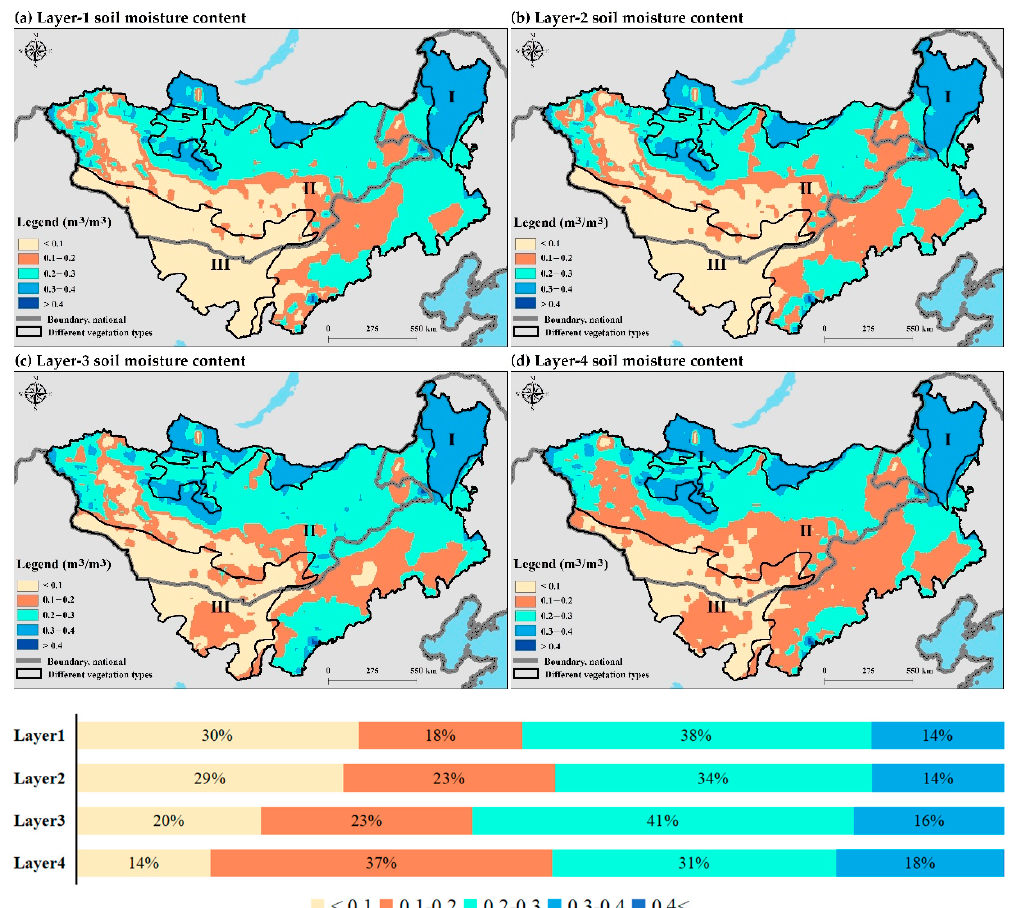
Figure 3. Spatial distribution of mean annual soil moisture at various depths during 1982–2015 across the MP. The (a), (b), (c), and (d) represent the layer 1, layer 2, layer 3 and layer 4, respectively.